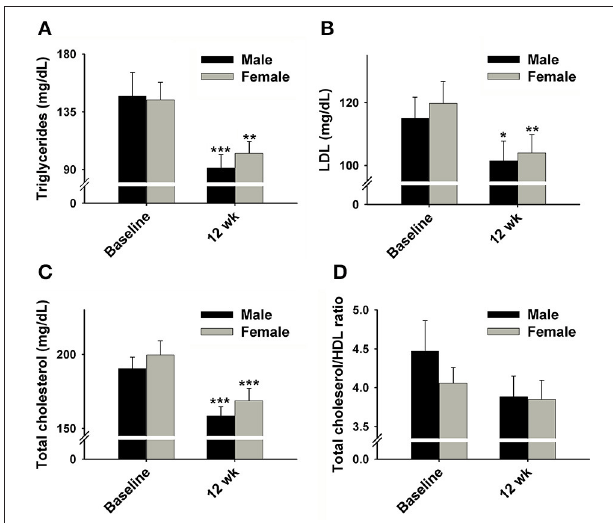
FIGURE 3 | Effect of 12 week HP-IF-LC intervention (Phase 1) on (A) triglycerides, (B) LDL, (C) total cholesterol, (D) total cholesterol/HDL ratio of males and females. Significant difference compared to baseline of the same gender indicated by: * p < 0.05; ** p < 0.01; *** p < 0.001. LDL, low-density-lipoprotein; HDL, high-density-lipoprotein.